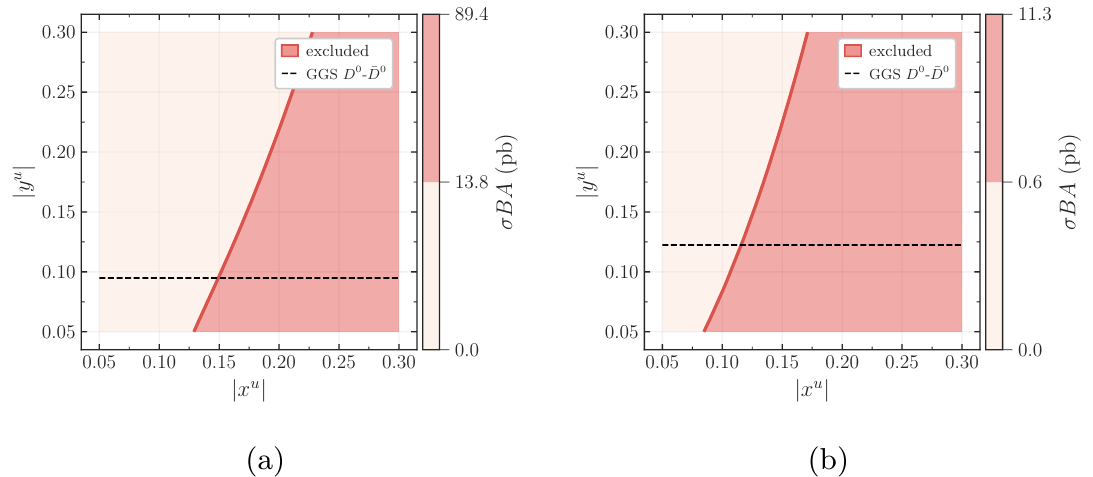
Figure 3 . Theoretical predictions of (cid:27)BA for the D u diquark with (a) M M D u = 1 TeV for di(cid:11)erent values of the light-quark coupling y u . The observed 95% CL upper limit on (cid:27)BA [43] is indicated by the red solid line. The black j j dashed line denotes the GGS constraint on